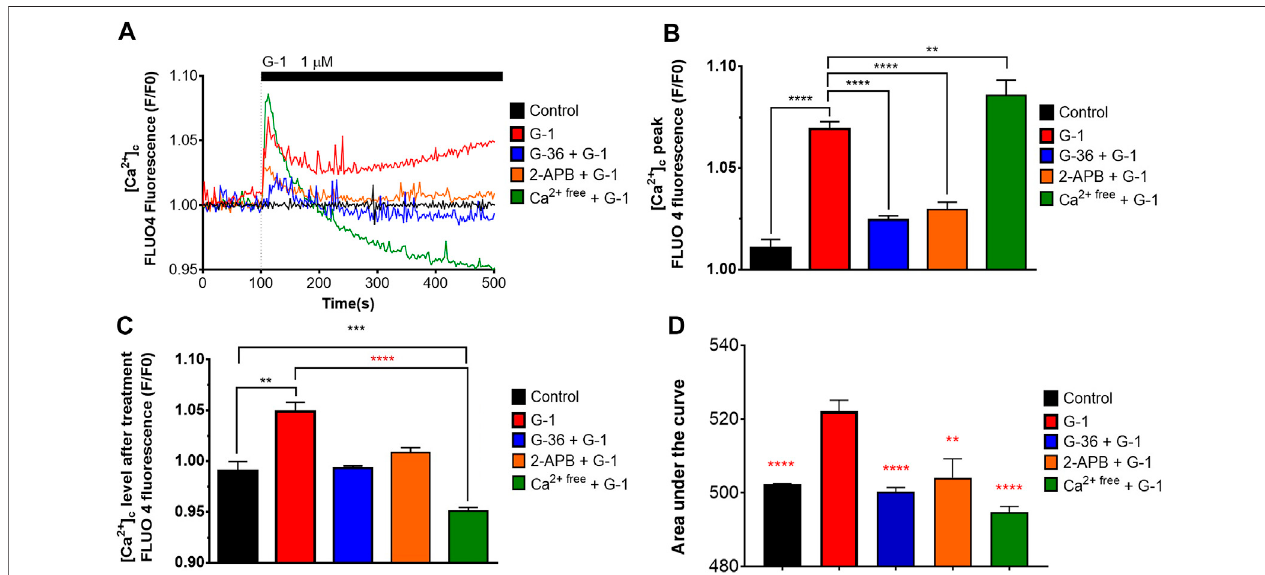
FIGURE 3 | Cytosolic Ca 2+ rise induced by G-1 in Jurkat cells is mediated by the GPER. (A) [Ca 2+ ] c monitoring in Jurkat cells loaded with Fluo 4. The time of G-1 injectionisindicated.Tracesrepresentthemeanofatleastsixsamplesfromthreeindependentexperiments. (B – D) Peak (B) ,steadystateat500 sofmonitoring (C) and the area under the curve, AUC (D) of [Ca 2+ ] c transients. Data are mean + SEM for at least six samples from independent experiments. For statistical analysis, one-way ANOVA was used. In (B – D) , the means were compared to the G-1 – treated mean value. In (C) , comparisons with control (black asterisks) and with G-1 – treated values (red asterisks) were conducted (** p < 0.01, *** p < 0.001, **** p < 0.0001).